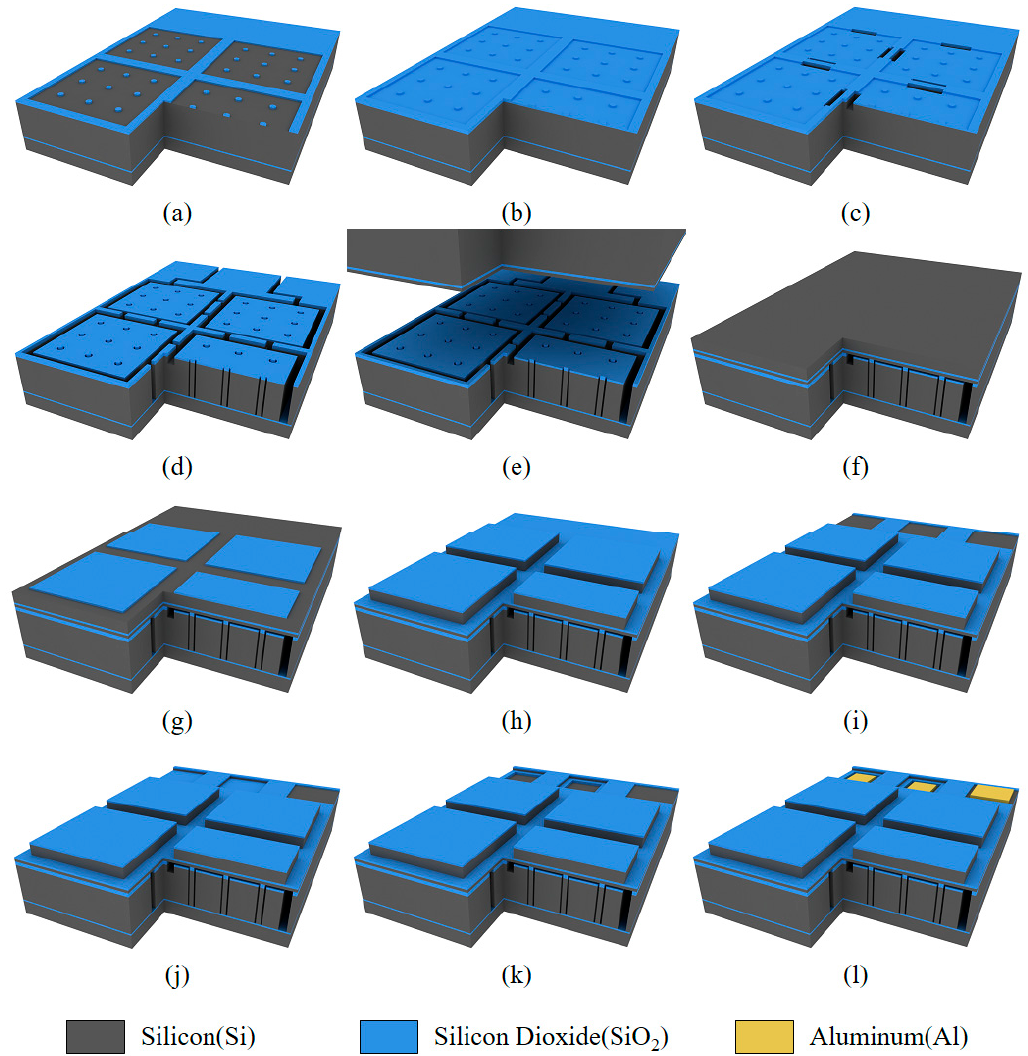
Figure 3. The fabrication process flow of the CMUT with substrate-embedded springs. ( a ) 250 nm silicon dioxide patterning for vacuum gap area; ( b ) Thermal oxidation for defining 150 nm vacuum gap height; ( c ) Formation of electrical connection bridges using RIE; ( d ) DRIE process step for defining four CMUT cells and 36 silicon spring posts; ( e ) Direct wafer fusion bonding of the processed bottom SOI wafer and a top blank SOI wafer; ( f ) Wafer grinding and polishing for piston top plate; ( g ) Thermal oxidation and patterning for top plate mask; ( h ) DRIE step for piston top plates; ( i ) BOX layer opening for electrical contacts; ( j ) Silicon device layer etching for bottom electrode access; ( k ) BOX layer etching for bottom electrodes; ( l ) Metal deposition and patterning for three electrode pads.